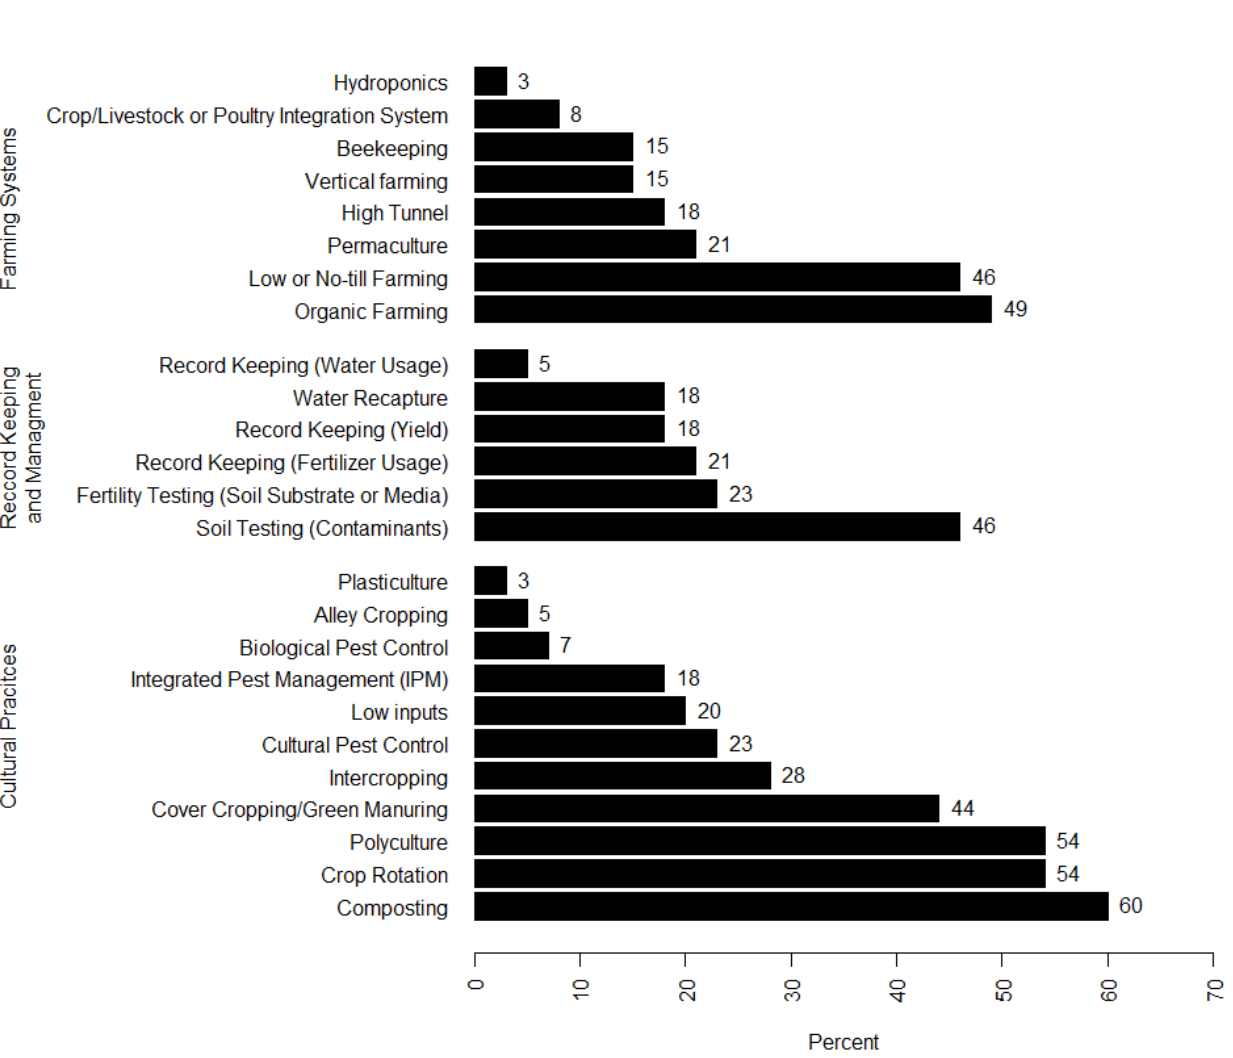
Figure 2. Sustainable urban farming practices/production techniques performed by survey participants ( n = 40). These practices are not mutually exclusive.